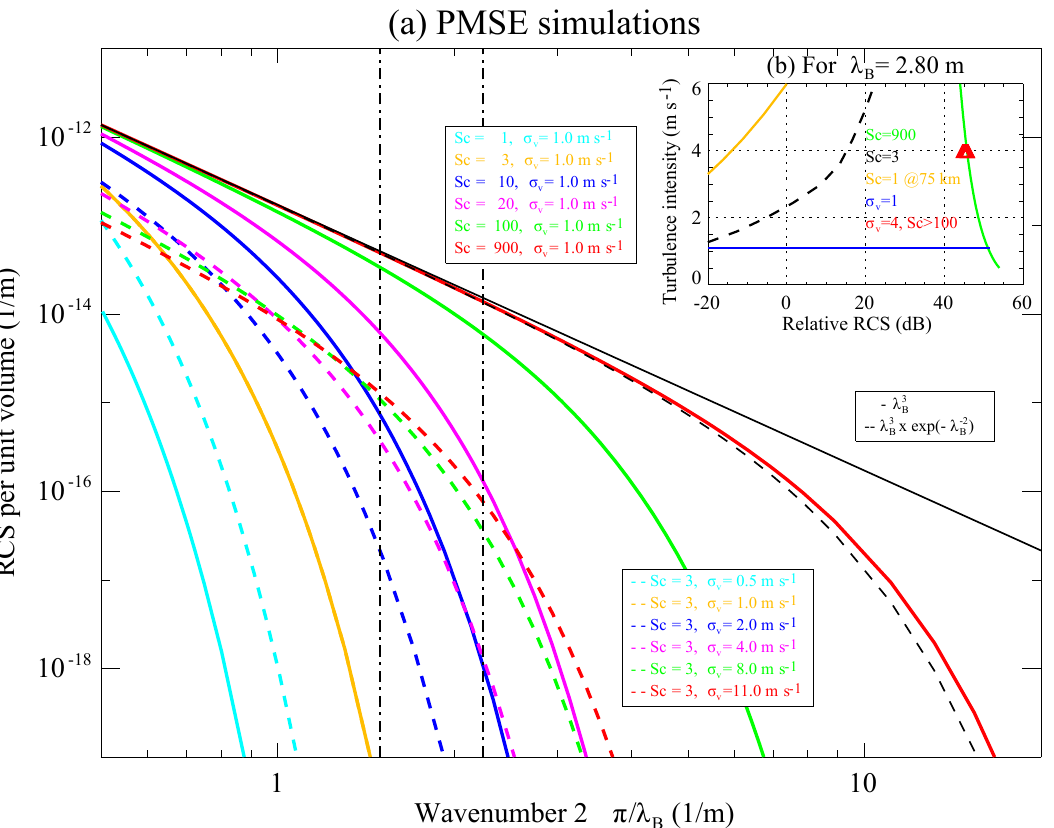
Figure 1. Simulations of PMSE RCS as a function of (a) wavenumber and (b) turbulence intensity at a λ B = 2 . 8m. In (a) we show two simulations, one keeping S c = 3 constant and varying σ v and the second one keeping σ v = 1 . 1 constant and varying S c . Two approximate dependence on λ B are shown in black (Varney et al., 2011, Eq. 44). In the case of (b) , five cases are shown (see text for details). The two vertical dashed lines represent the wavenumbers of interest, i.e., bistatic middle point (smaller) and MAARSY monostatic